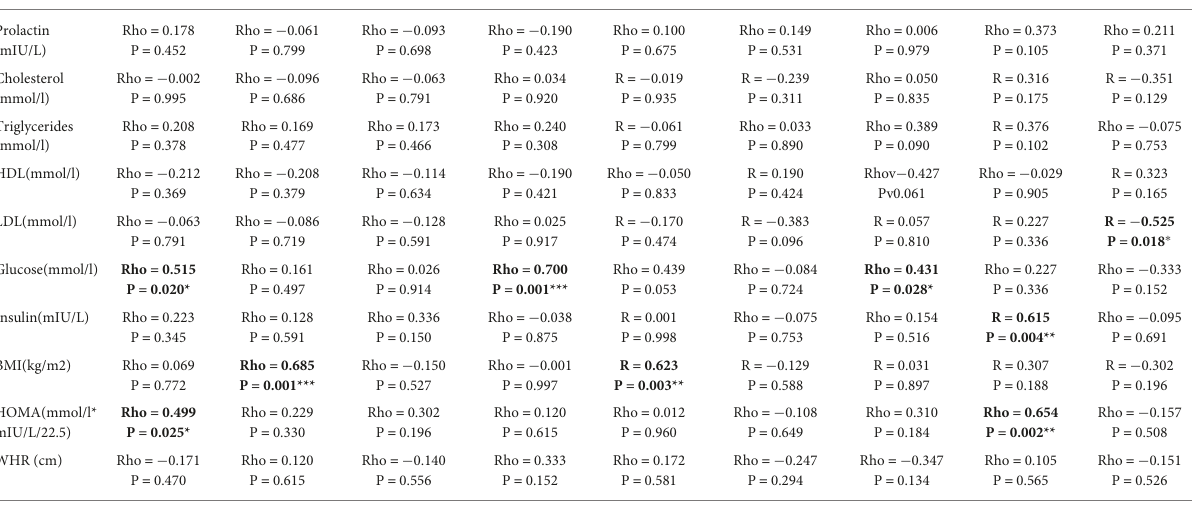
TABLE 5 Correlation of observed metabolic variables and measured cytokines in each group of patients. TNF- α IL-33 TGF- β